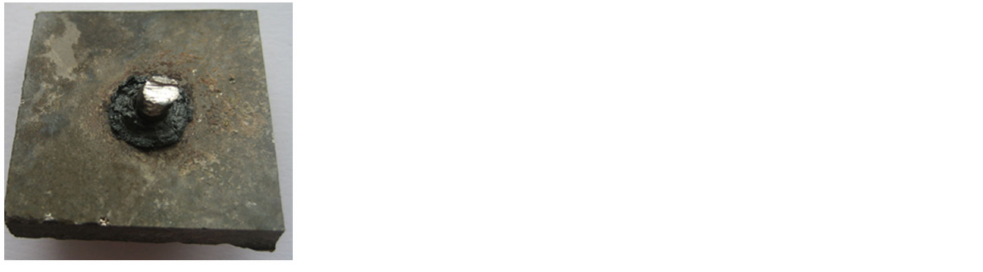
Figure 14. Photo of the NiAl intermetal sample after exposure in the boiler combustion chamber.